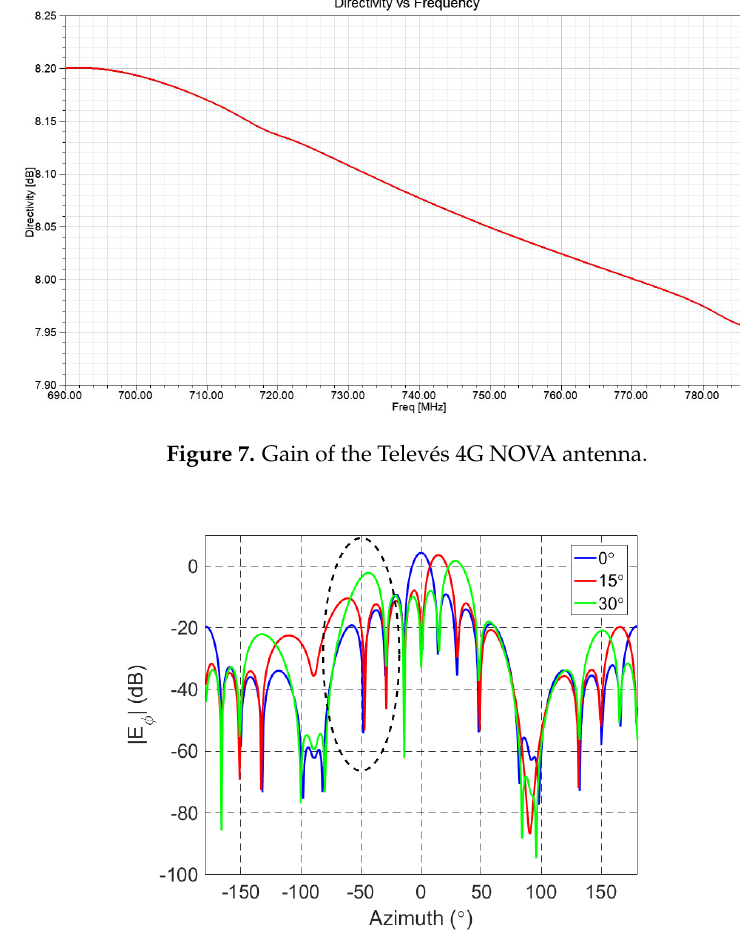
Figure 8. Azimuth plane radiation pattern of the ULA with five Televes 4G NOVA antennas, for 770 MHz, inter-element spacing equal to 315 mm and three steering directions: 0 ◦ (broadside), 15 ◦ and 30 ◦ . The effect of grating lobes is marked with an